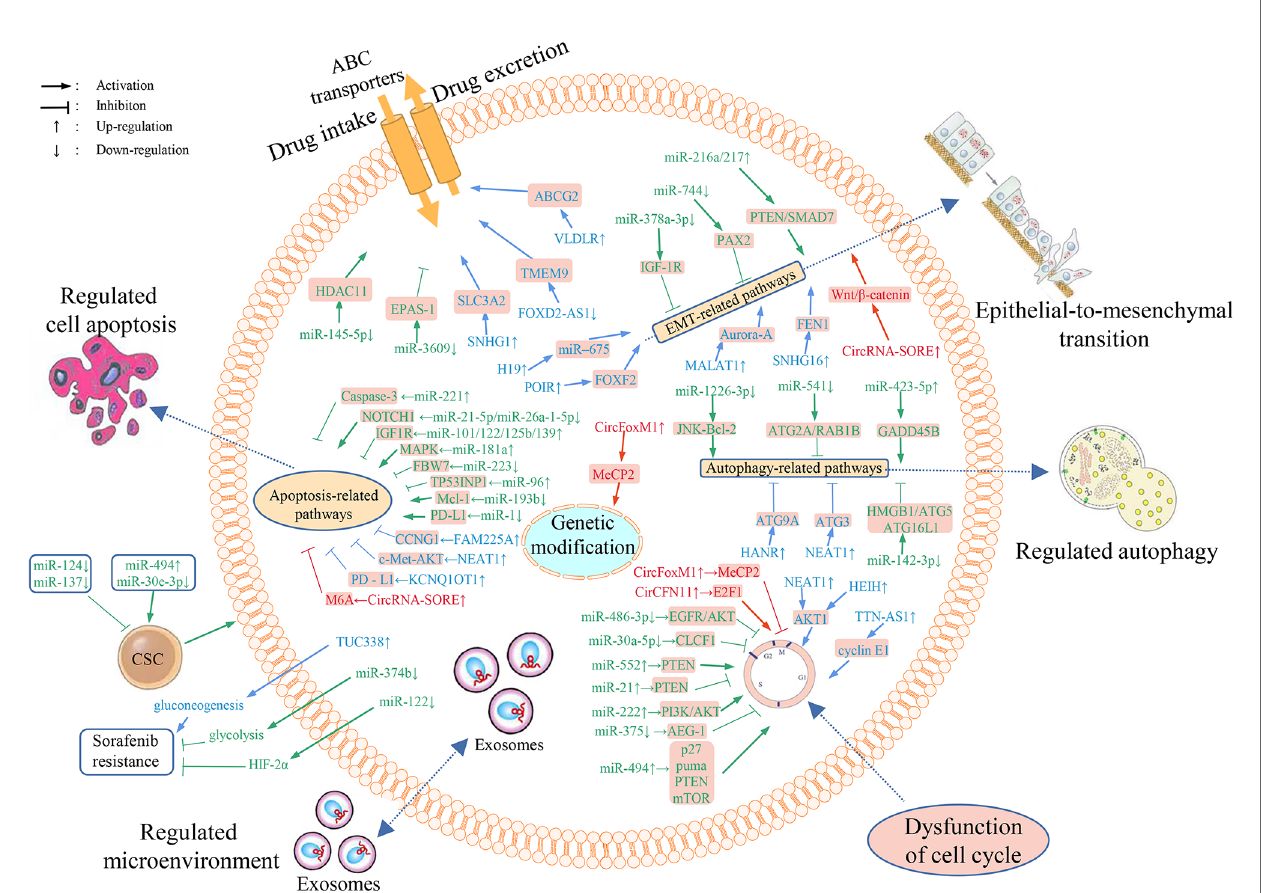
FIGURE 1 | Overview of the mechanisms of ncRNAs involved in HCC resistance to sorafenib and dysregulated ncRNAs ’ differential expression in sorafenib resistant HCC cells. Numerous miRNAs, lncRNAs and circRNAs are implicated in sorafenib resistance through regulating the expression of downstream target genes and affecting drug transport, metabolism, cell multiplication, autophagy, apoptosis, cell cycle, EMT, tumor microenvironment, and gene modi fi